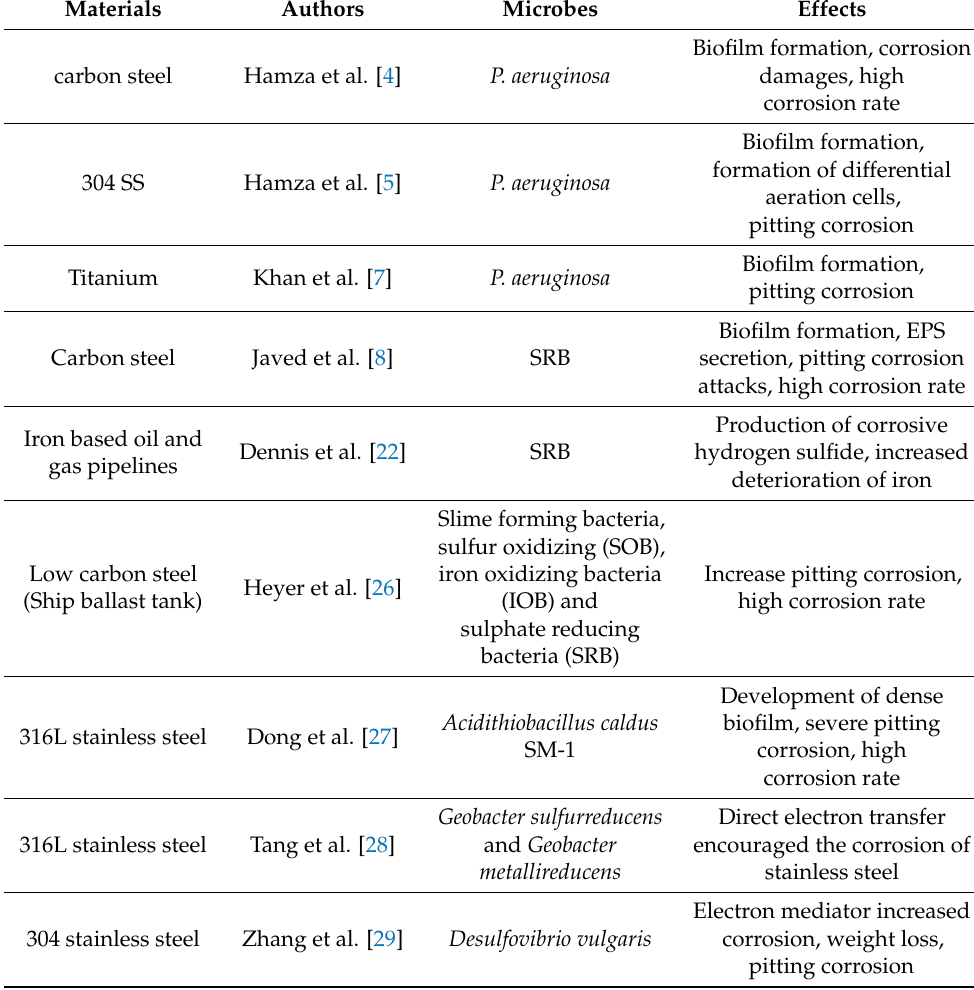
Table 1. The main findings of the researchers in the field of MIC of metallic